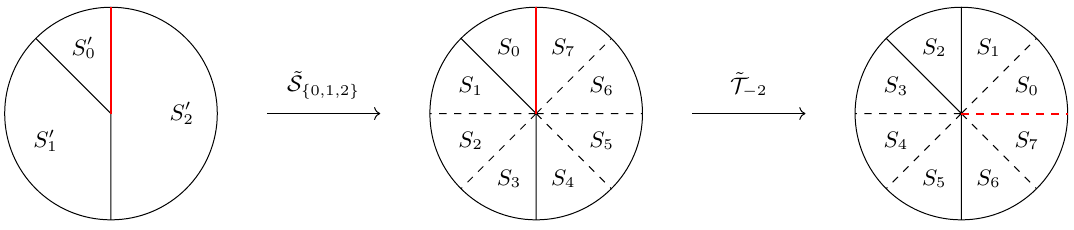
Figure 6 . Pictorial representation of the action of ( R (2 , (1 , 3 , 4)) ) † on boundary conditions. The right adjoint maps B (1 , 0)